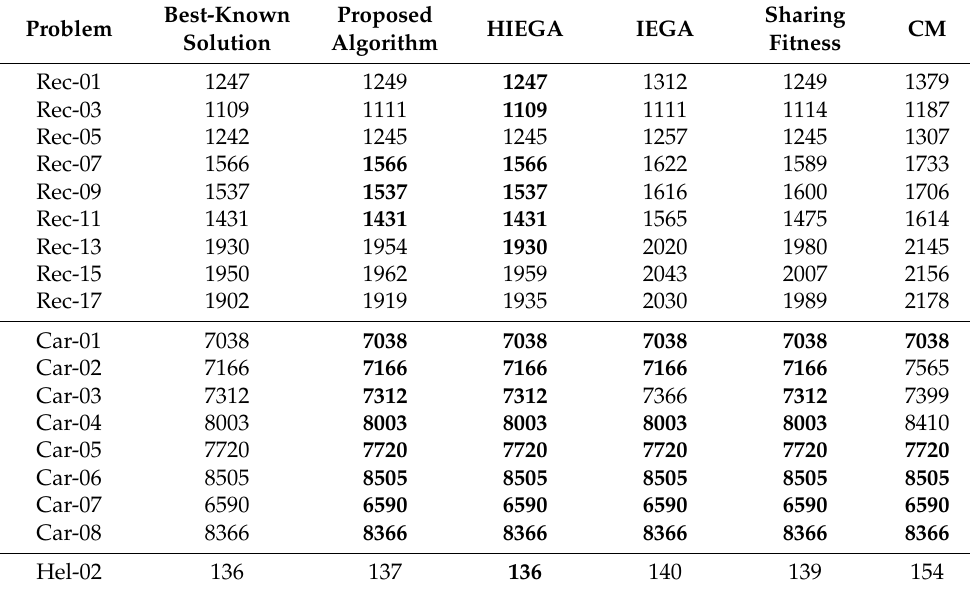
Table 2. Best optimal solution obtained by the different